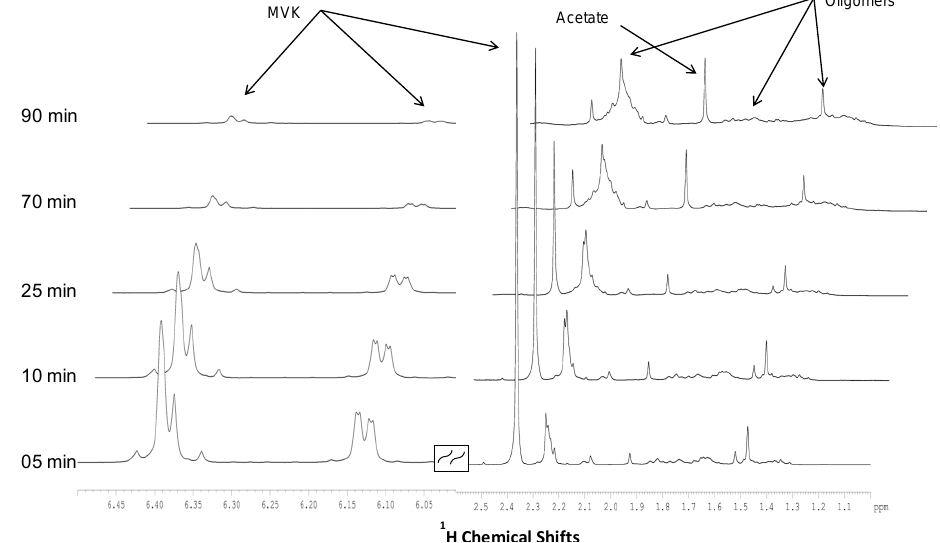
Fig. 2. Monitoring experiment A by 1D 1 H NMR (recorded in phosphate buffer containing 10% D 2 O). The intensities of oligomer structures increase with time, to the detriment of MVK.